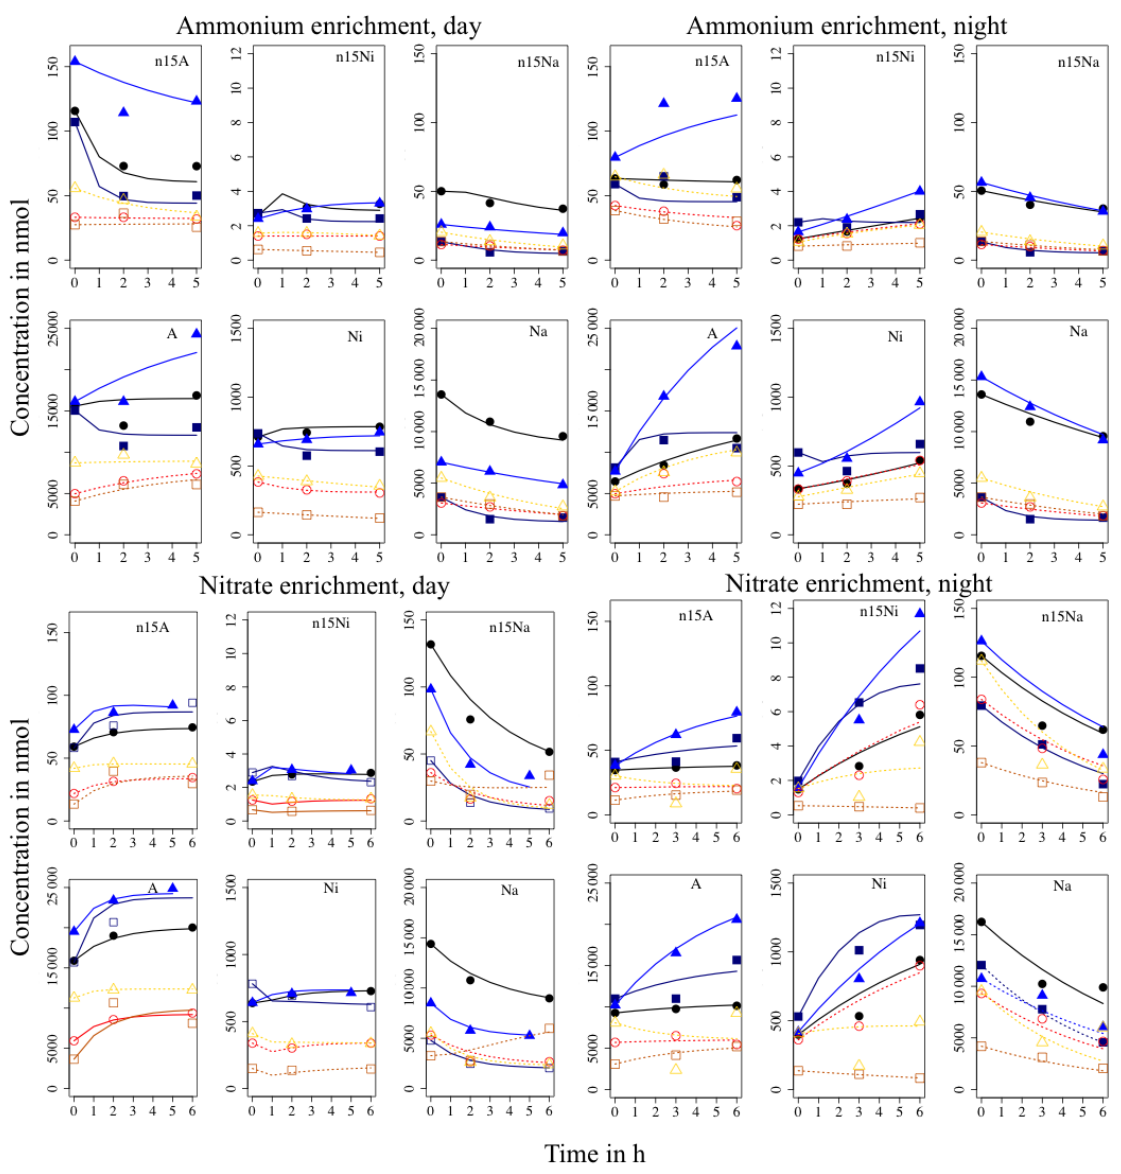
Figure 3. ODE modeled 15 N fits to the data for six representative tidepools in all four enrichment experiments. The ODE model was fit individually to each tidepool, designated with unique colors and symbols. Measurements are shown with symbols, while model fits at each time point are designated with lines; filled symbols with solid lines are three separate tidepools with mussels, while open symbols with dashed lines are three tidepools where mussels were removed. The lines thus represent the differential equation model (Eqs. 2–7) fit based on the modCost function using sum of squares. The symbols are the measured values (in nmol 15 NL − 1 ) for the corresponding tidepool at each time point; note difference in axes for nitrite. Note that although tidepools differed greatly in their nutrient dynamics, the model fits are generally close to the measured